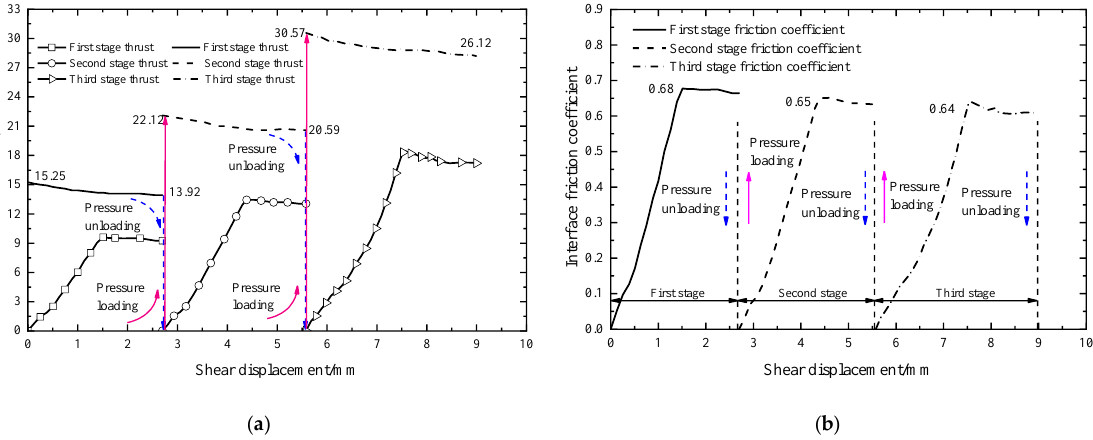
Figure 10. Interface shear test results of the T R14d group: ( a ) Load displacement curve of the T R14d group and ( b ) Friction coefficient displacement curve of the T R14d group.